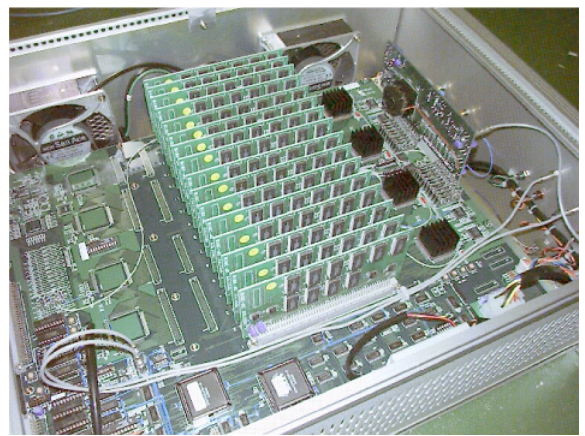
FIG. 8. (Color) Photograph of the bunch current monitor/large- scale memory board.